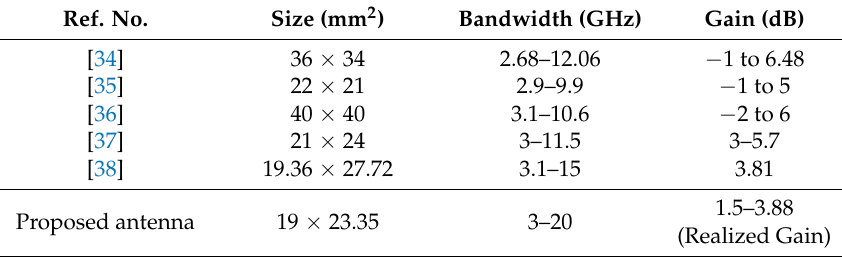
Table 4. Comparison of the proposed antenna with previous